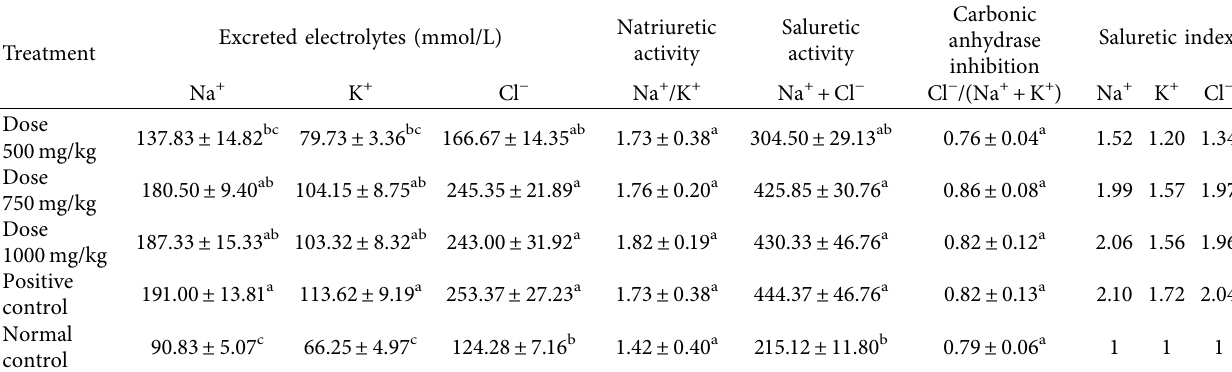
Table 6: Electrolyte extraction in the treated rats using the microencapsulated bioactive product.